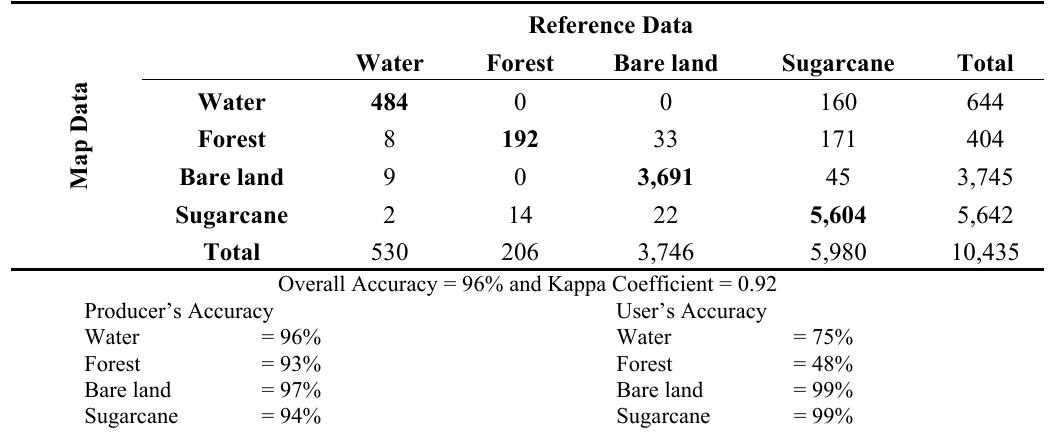
Figure 6. The LULC mapping of Nakhon Ratchasima Province (cassava site). ( a ) THEOS. ( b ) Landsat 5 TM and Suphanburi Province (sugarcane site). ( c ) THEOS. ( d ) Landsat 5